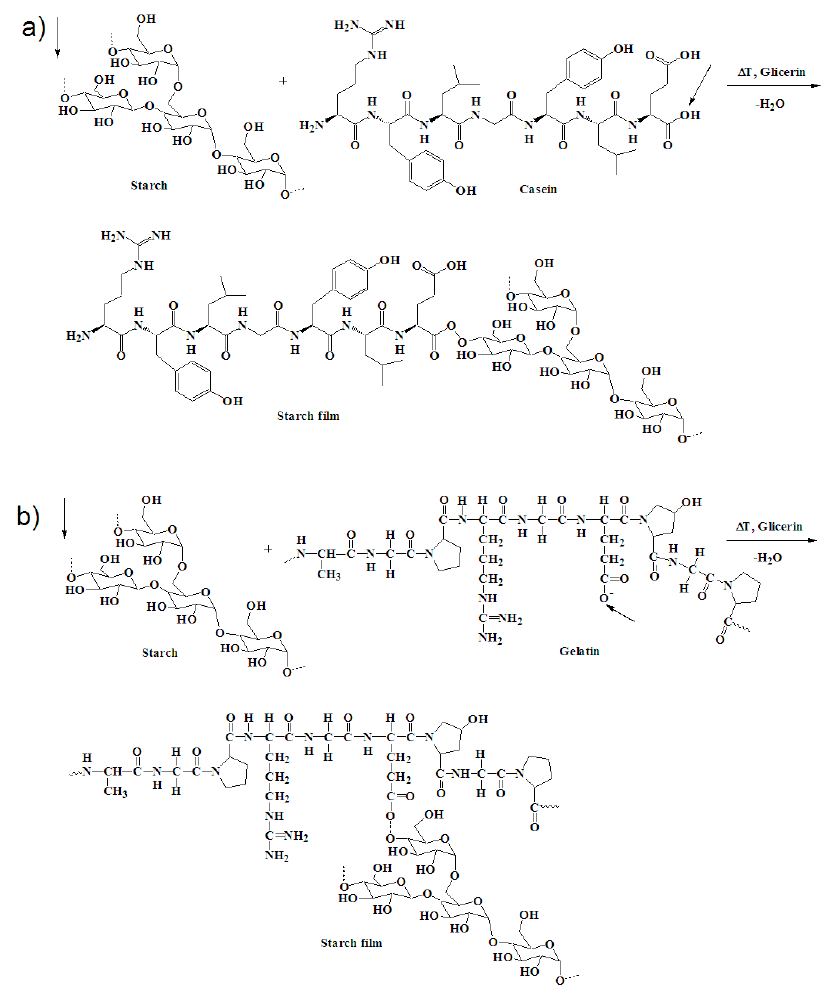
Figure 3. Probable interactions between starch and casein macromolecules ( a ) and between starch and gelatin ( b ).